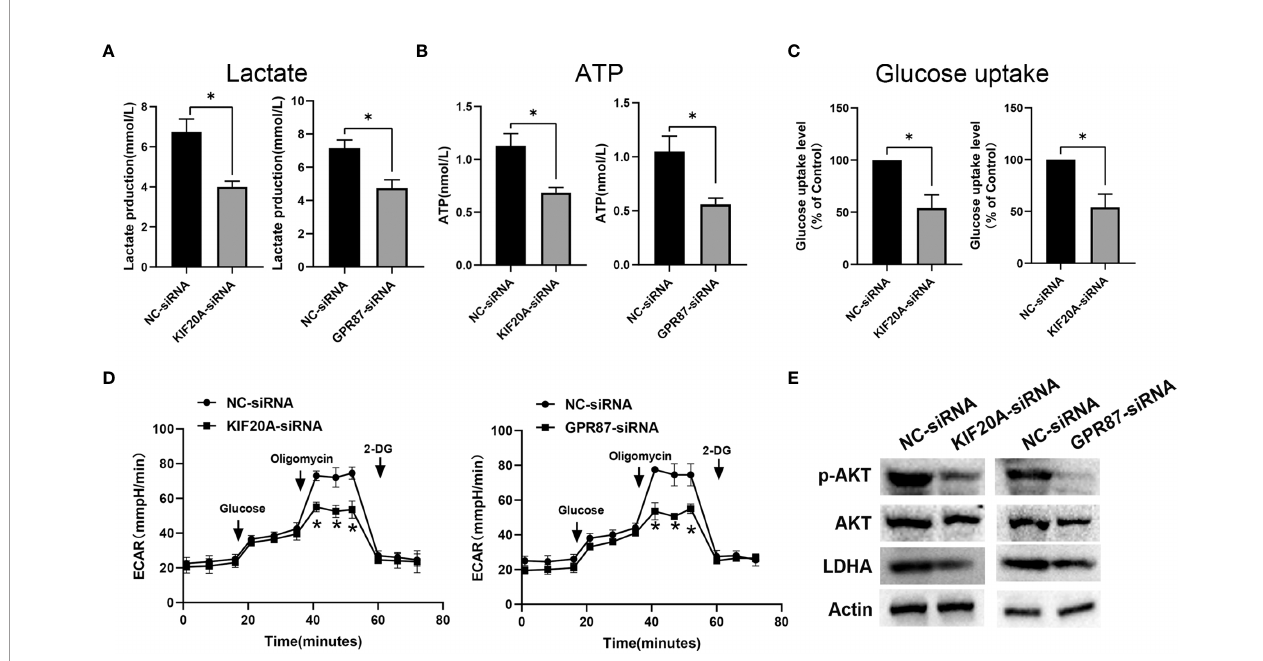
FIGURE 10 | KIF20A and GPR87 regulate glycolysis in melanoma cells. Levels of (A) lactate, (B) ATP, (C) glucose uptake and (D) extracellular acidi fi cation rates (ECAR) as measured and analyzed in A375 cells transfected with NC-siRNA, KIF20A-siRNA or GPR87-siRNA. (E) Western blot analysis in A375 cells transfected with NC-siRNA, KIF20A-siRNA or GPR87-siRNA. *p <